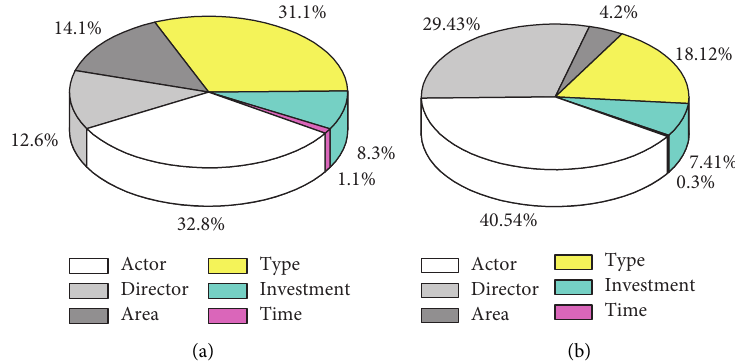
Figure 4: (a) The influence of various factors on film box office and score. (b) The influence of various factors on TV ratings and score.